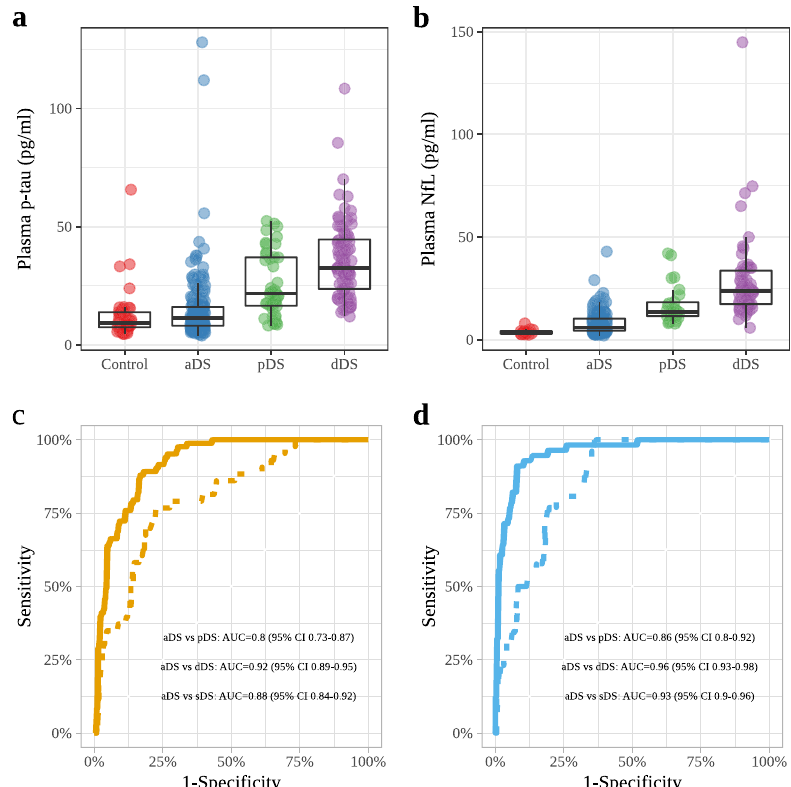
Fig. 2 Plasma p-tau181 and NfL concentrations in Down syndrome clinical groups and controls. a , b Box and whisker plots of the median concentrations of plasma p-tau181 and plasma NfL. Plasma p-tau181 concentrations a for aDS ( n = 240), pDS ( n = 43), dDS ( n = 83) and euploid controls ( n = 44) and plasma NfL concentrations b for aDS ( n = 193), pDS ( n = 26), dDS ( n = 56) and euploid controls ( n = 14). The central black lines indicate the median values. The boxes above and below these lines show the upper and lower quartiles, respectively, and the whiskers illustrate upper and lower 1.5× IQR limits. c , d ROC curves for plasma p-tau181 ( c ) and NfL ( d ) comparing the asymptomatic group with the Alzheimer ’ s disease dementia (full curve) and with the prodromal Alzheimer ’ s disease group (dotted curve). ROC receiver operating characteristic, NfL neuro fi lament light protein, p-tau tau phosphorylated at threonine 181.